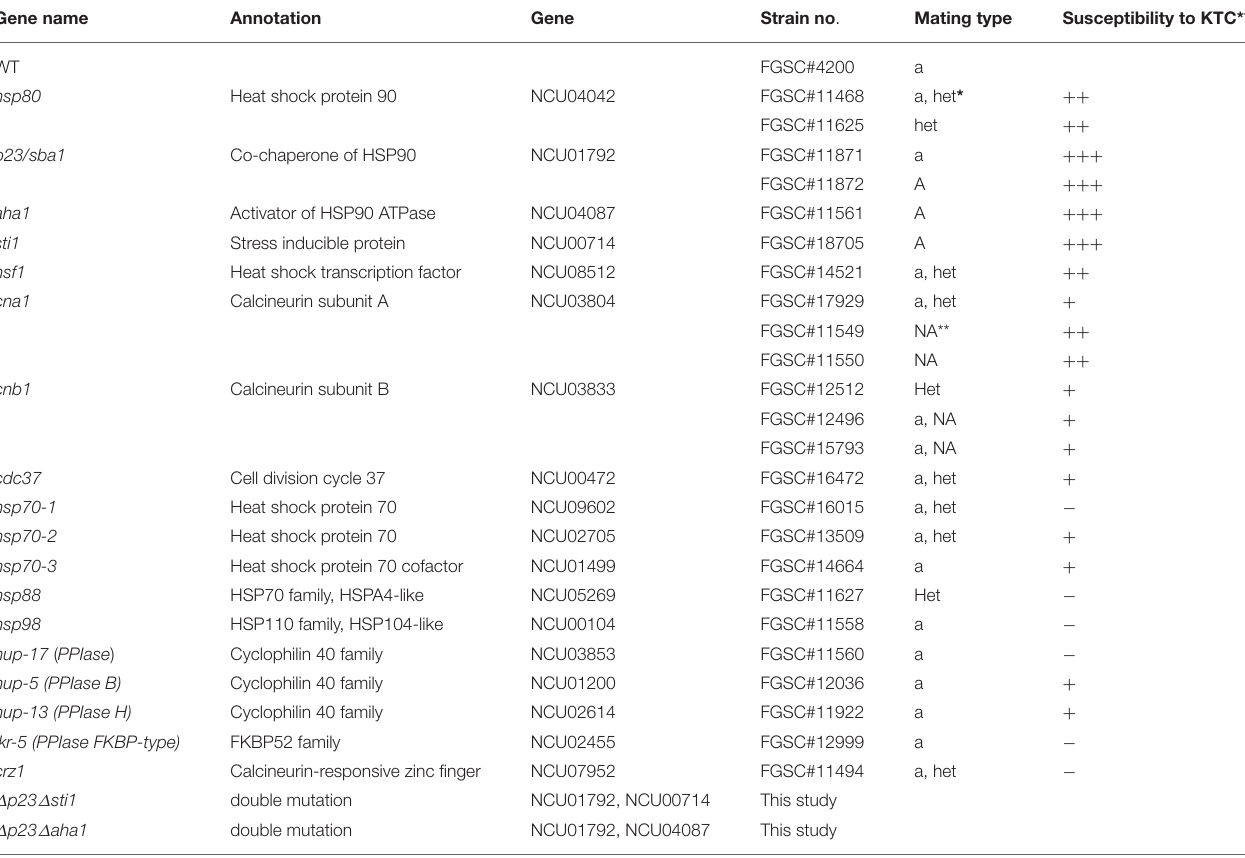
TABLE 1 | N. crassa strains used in this study and their susceptibility to ketoconazole